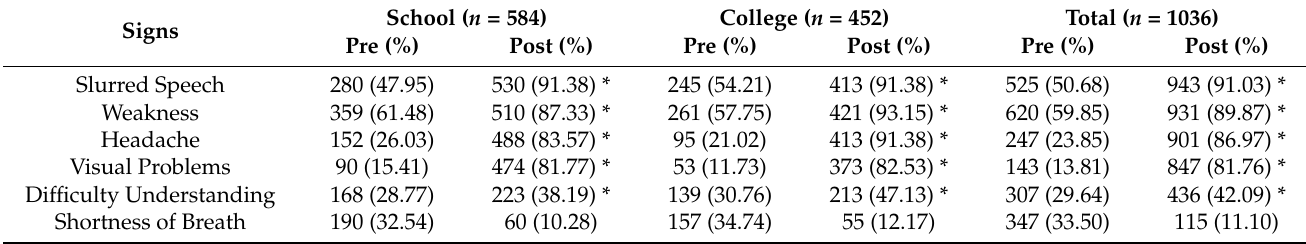
Table 2. Knowledge about symptoms of stroke.